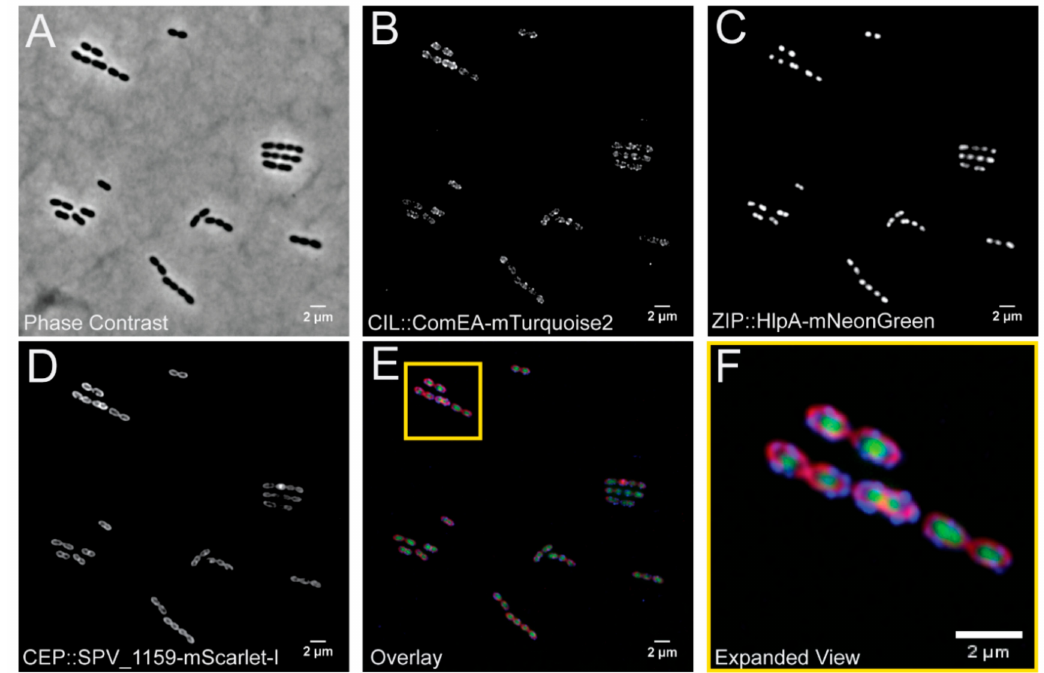
Figure 4. Visualization of a pneumococcal strain VL2706 expressing three di ff erent fluorescent fusions simultaneously from the three di ff erent integration loci. From the CEP locus (PEPX): ComEA-mTurquoise2; from the CIL locus (PEPY): SPV_1159-mScarlet-I; and from the ZIP locus (PEPZ): HlpA-mNeonGreen. Integration of the three constructed vectors produced distinct localizations based on the proteins used for the fusion. ( A ) A phase contrast image of VL2706. ( B ) The ComEA-mTurquoise2 fusion produced strong foci around midcell as well as at the poles of the cell as previously shown [31], ( C ) HlpA fusions produce distinct green signal that localizes at the chromosome [32,33], and ( D ) SPV_1159 fusions produce distinct membrane associated signals in the bacterial cells. ( E ) An overlay of the three simultaneously expressed fusion proteins and a yellow outline of ( F ) containing an expanded view of the